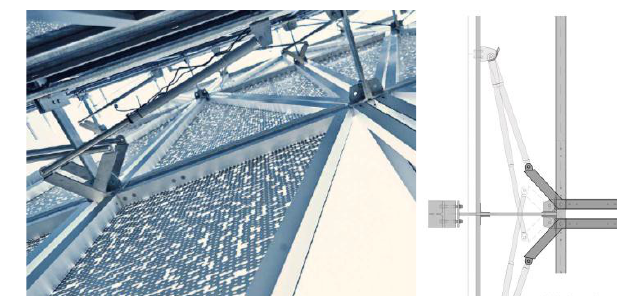
Figure 14. Exterior shot of SDU Kolding